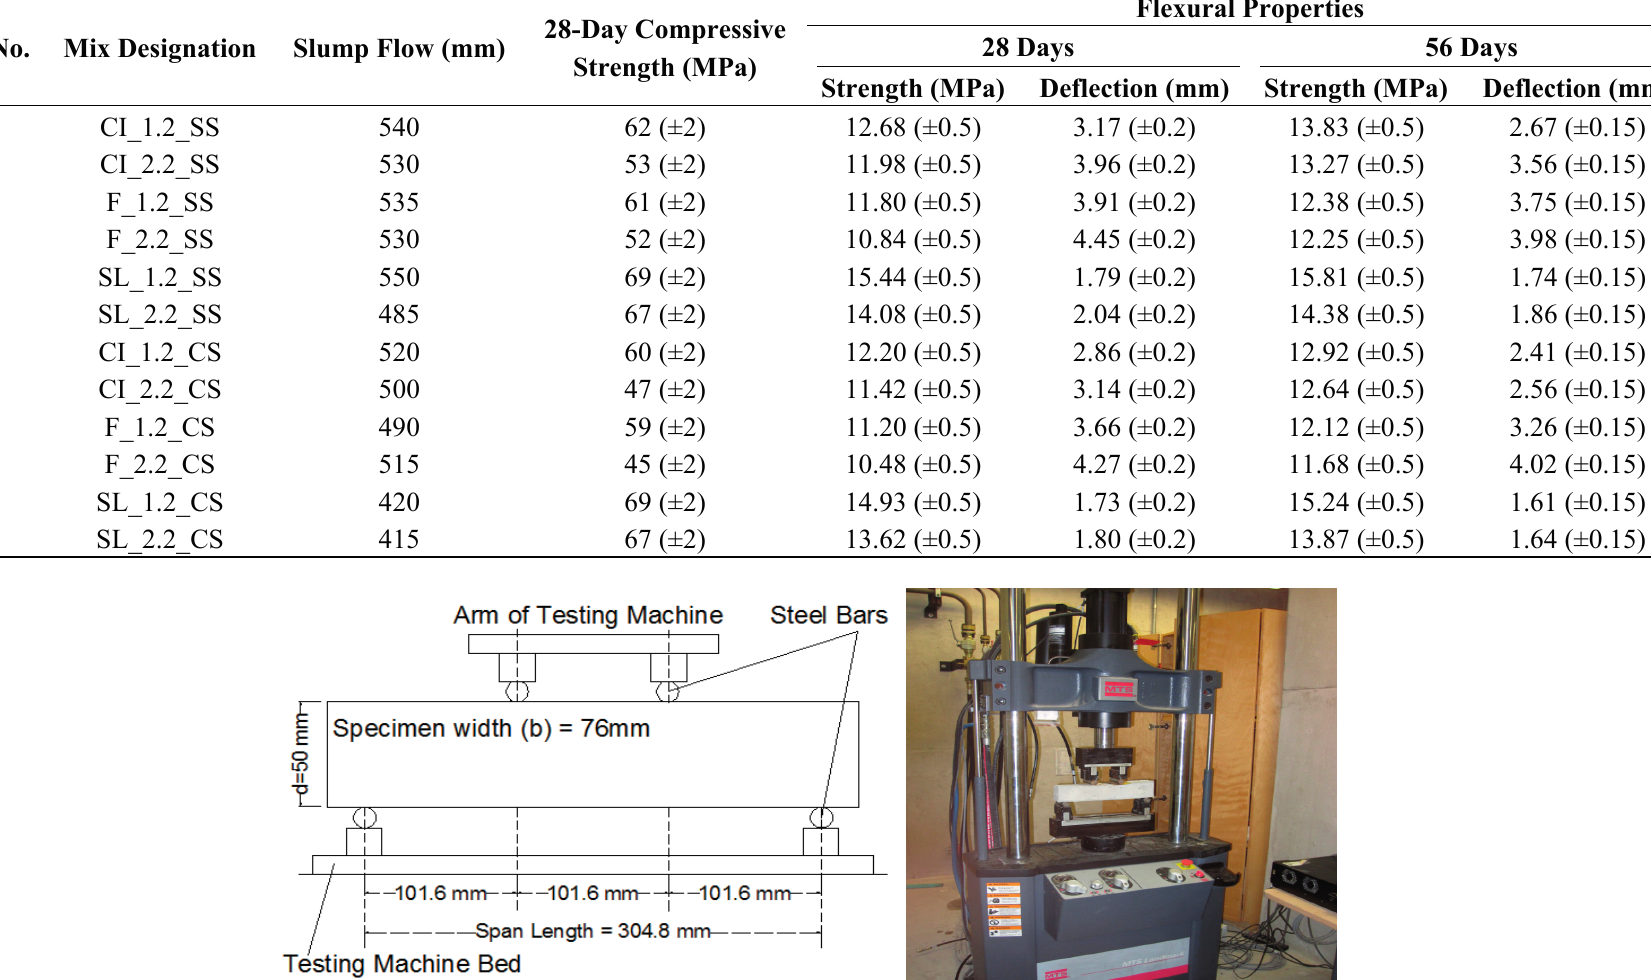
Figure 1. Four point bending test